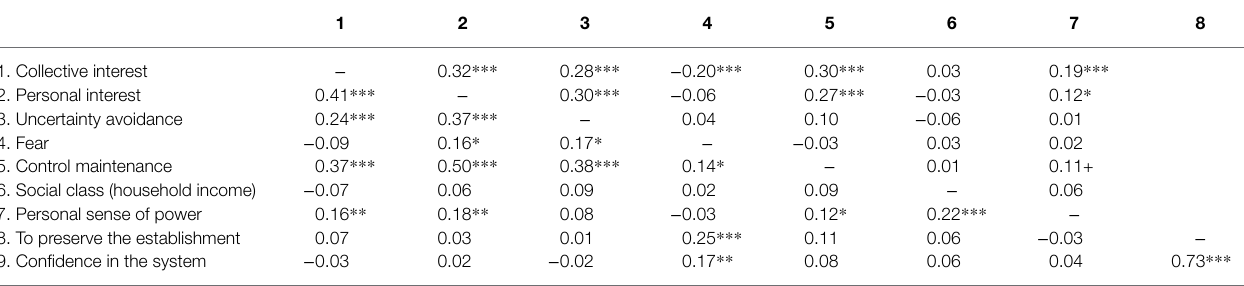
TABLE 1 | Zero-order bivariate correlation between mechanisms related to system justification and personal/collective